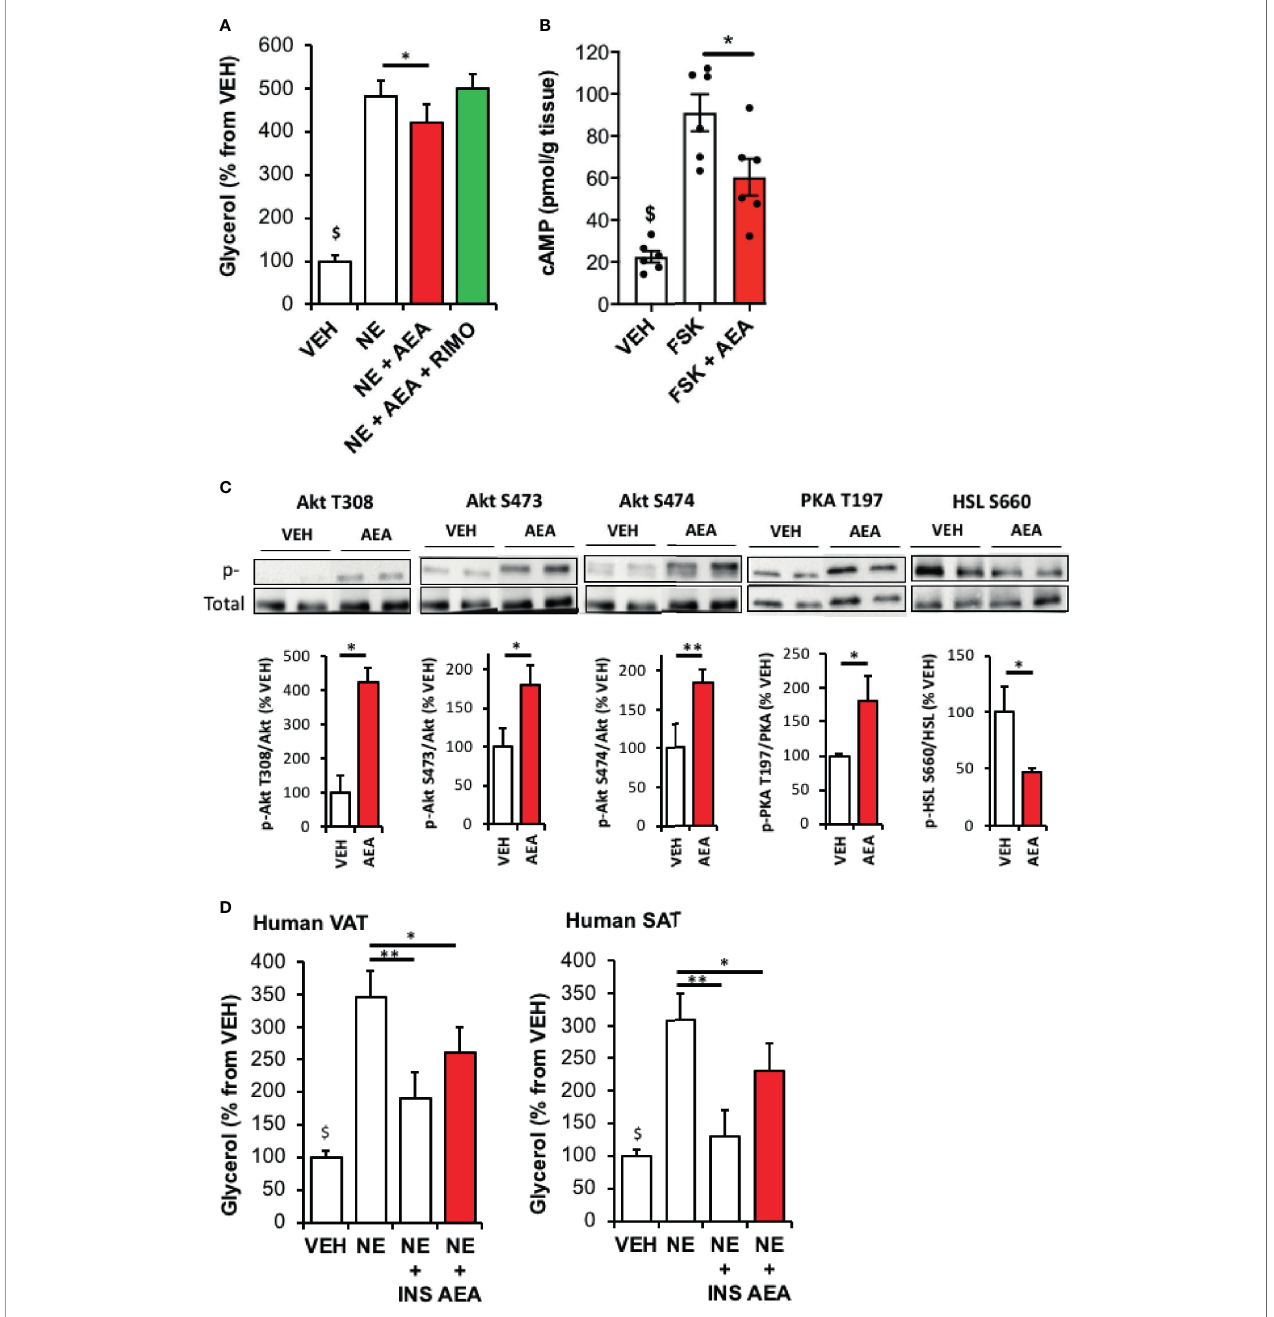
FIGURE 2 | CB1R activation by AEA decreases WAT lipolysis through an Akt-dependent mechanism. (A) Glycerol production by rat WAT explants pre-incubated 30 min with vehicle (VEH) or AEA (5 µM) and incubated 1 hour with VEH, AEA, AEA+Rimonabant (RIMO, 1 µM) in the presence of norepinephrine (NE, 1 µM). Explants were treated in triplicate and experiments repeated on 3 different rats (n=3/group). $ p < 0.001 VEH vs other treatments. (B) Intracellular cAMP content in rat WAT explants treated 15 min either with VEH, forskolin (FSK, 10 µM) or FSK+AEA (5 µM). Explants were treated in triplicate and experiments repeated on 3 different rats (n=3/group). $ p < 0.001 VEH vs other treatments. (C) Representative immunoblots and densitometry analyses of the phosphorylation level of Akt (T308, S473, S474), PKA-C (T197) and HSL (S660) in rat WAT explants treated 15 min with VEH or AEA (5 µM). (D) Glycerol production by Human TAV or SAT explants pre- incubated 30 min with VEH or AEA (5 µM) and incubated 1 hour with VEH, AEA or insulin (INS, 500 nM) in the presence of norepinephrine (NE, 1 µM). Explants were treated in triplicate and experiments repeated on 7 different subjects (n=7/group). $ p < 0.001 VEH vs NE and NE+AEA. Results are expressed as mean ± SEM. *p < 0.05; **p <